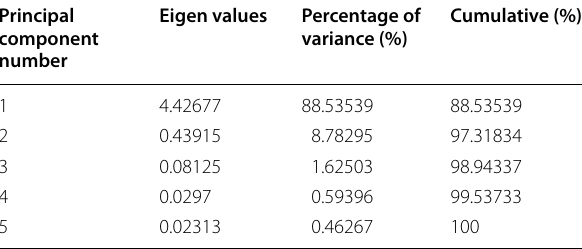
Table 4 Percentage rate of total variability explained by principal components obtained in the PCA analysis Principal